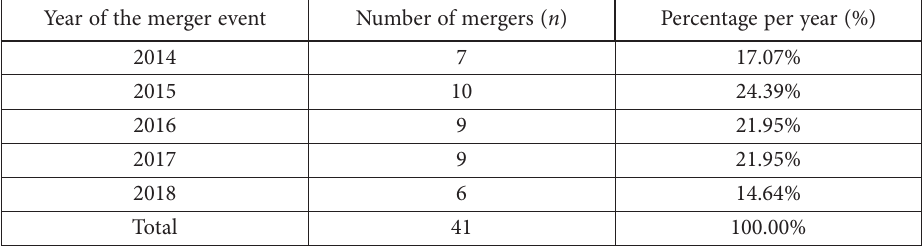
Table 1. Number and percent of mergers by year Year of the merger